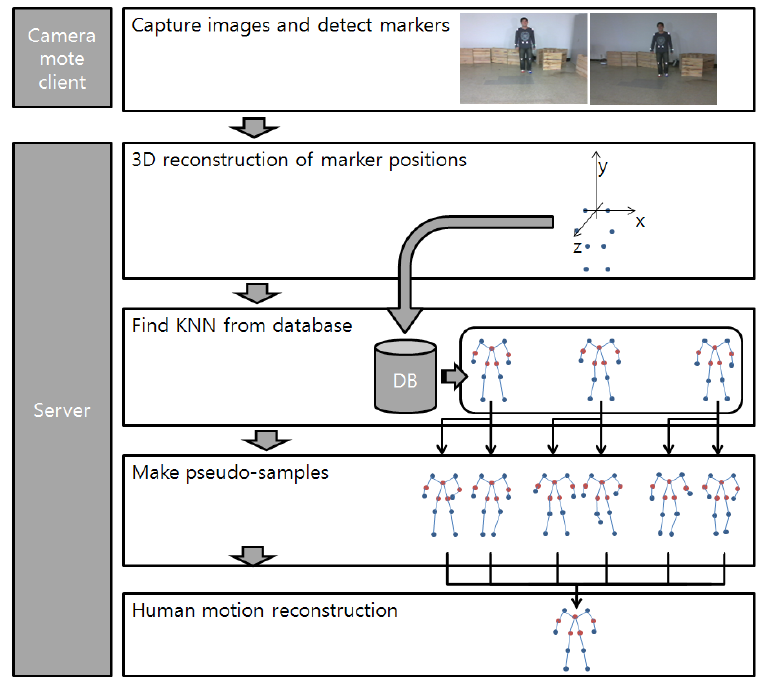
Figure 3. A flowchart of the Samba motion capture system based on a wireless camera sensor